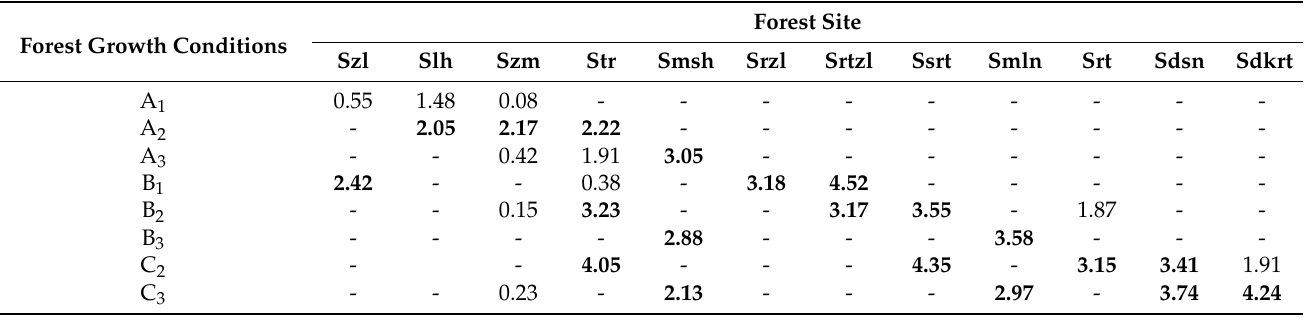
Table 6. Reliability of differences between the average values of burning indices in different forest site and forest growth conditions. Statistical differences ( p < 0.05) are marked by bold